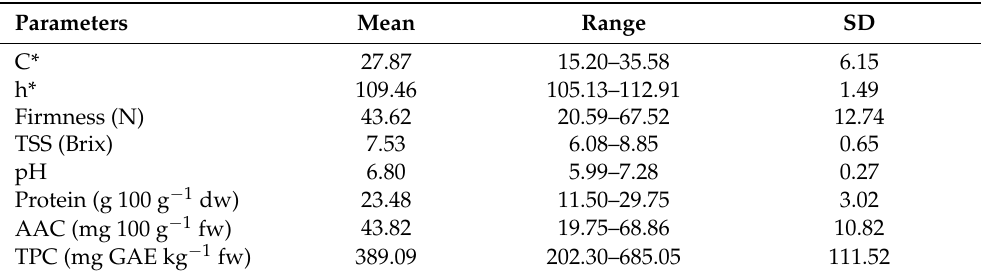
Table 2. Mean, range and standard deviation ( n = 144) for quality parameters of the mangetout samples used in this